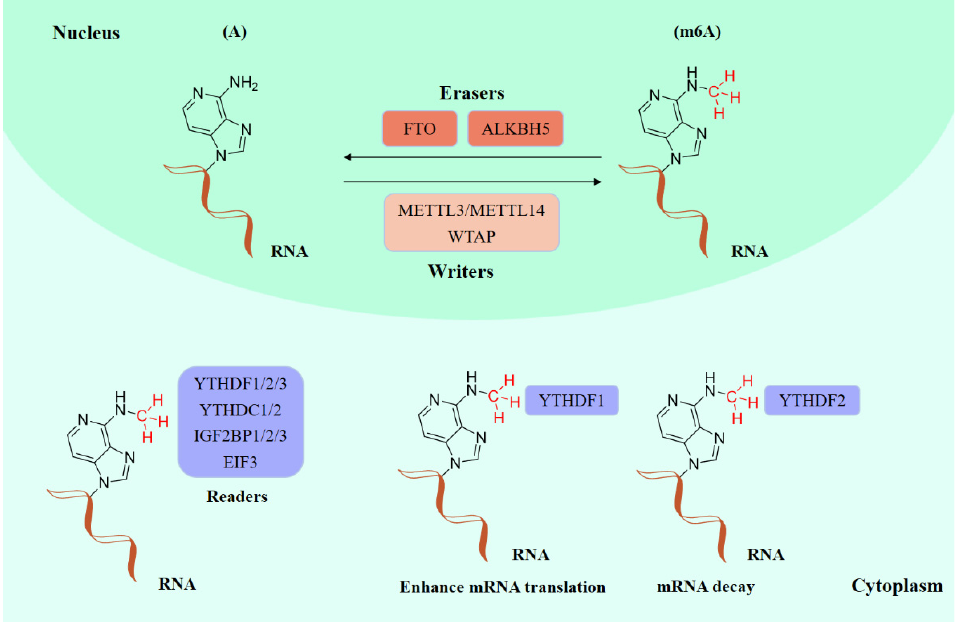
Figure 1. The molecular mechanism of m6A modifications.